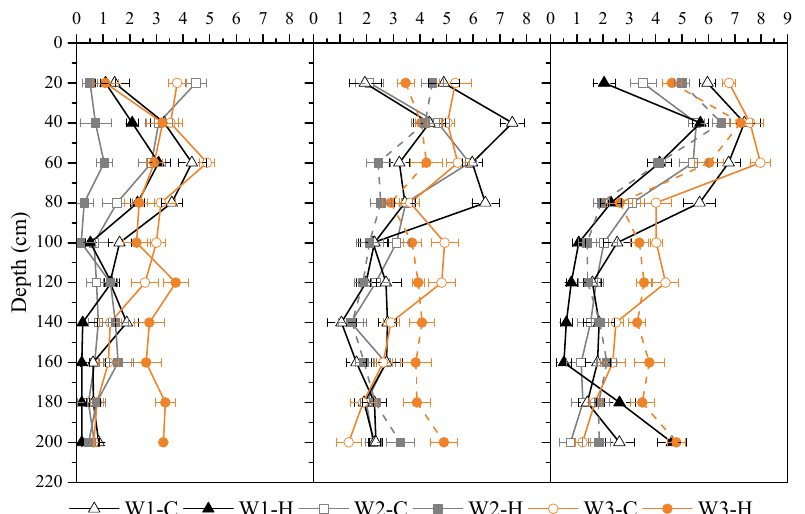
Figure 3. The soil moisture content in the low (W1), medium (W2) and high (W3) irrigation amounts during July, August and September of 2016. The C and H present C. mongolicum and H. ammodendron , respectively, same in the figures blow.